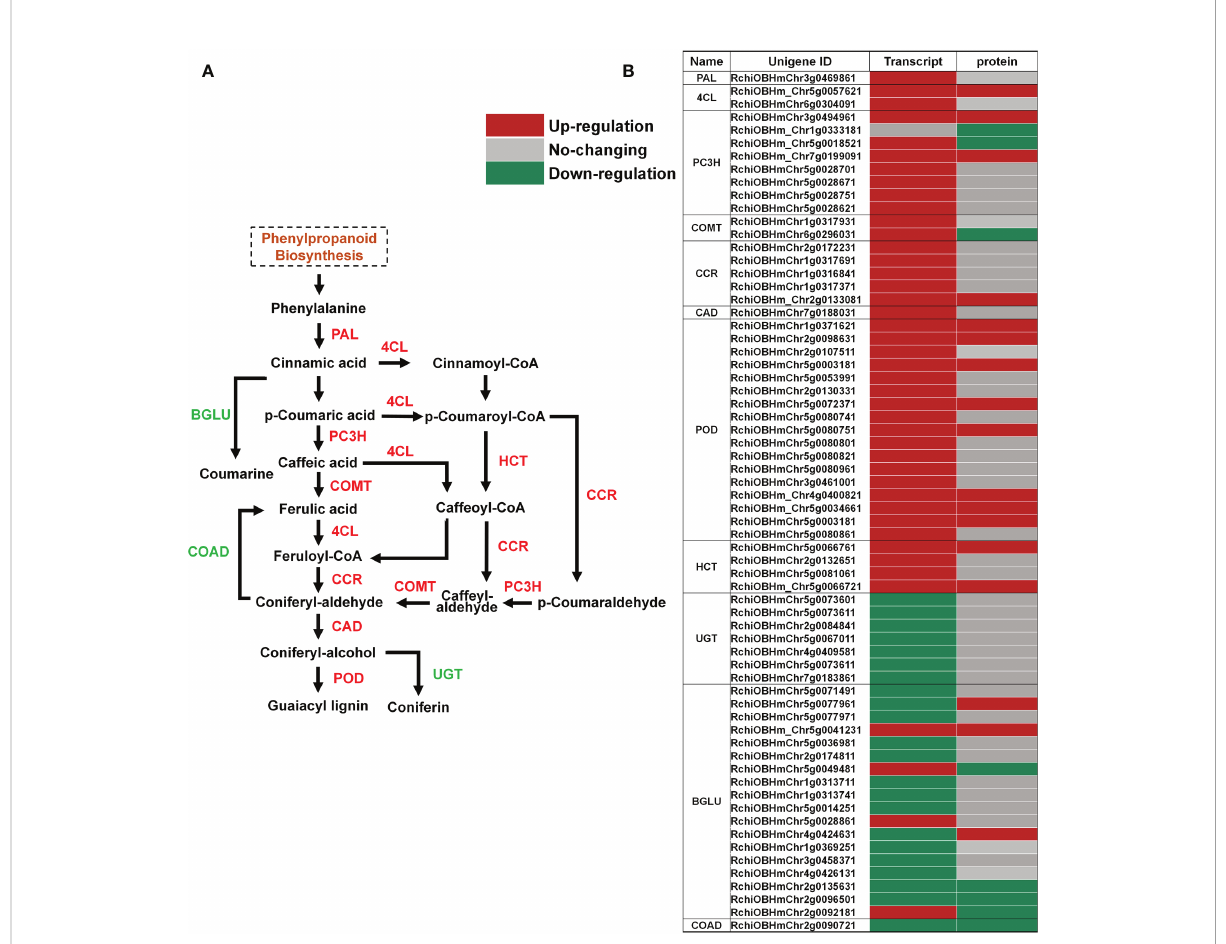
FIGURE 5 Changes in transcript and protein levels of phenylpropanoid biosynthesis pathway members in AZ during petal abscission. (A) Schematic of the phenylpropanoid biosynthesis pathway. (B) Expression of genes related to phenylpropanoid biosynthesis at transcript and protein